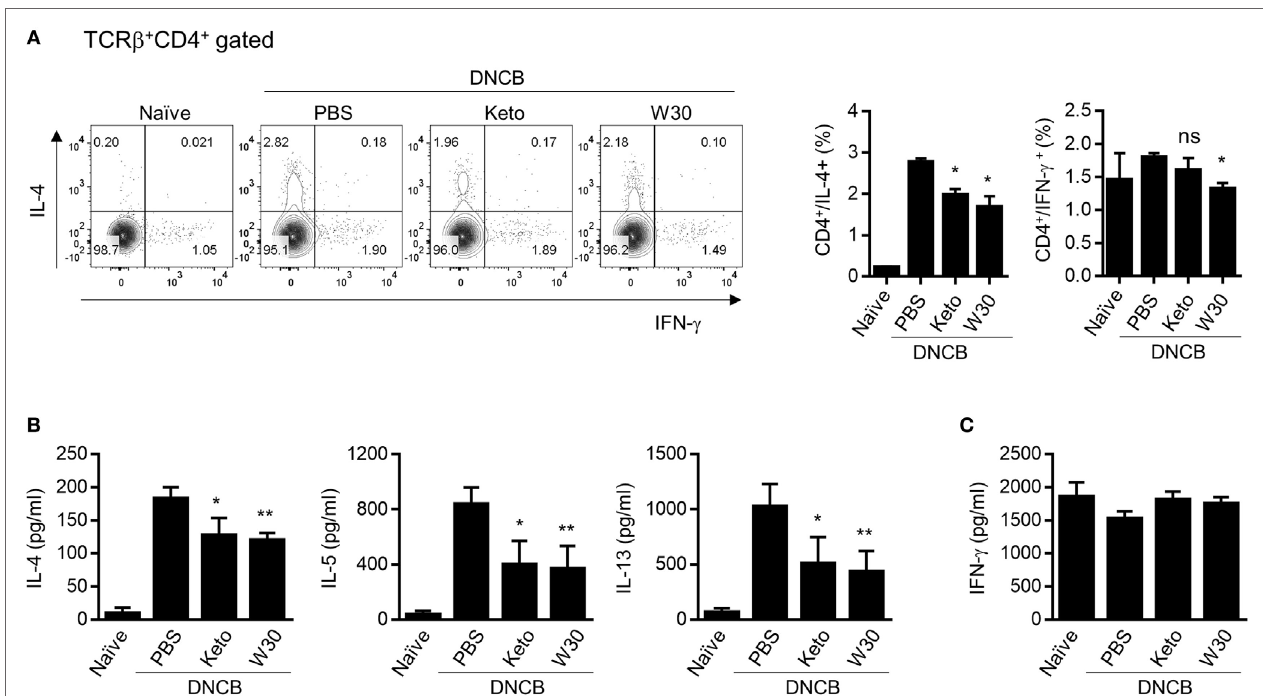
FigUre 3 | Inhibitory effect of T helper 2 immune responses in PLN cells of atopic dermatitis (AD) mice treated with WIKIM30. (a) PLN cells isolated from each group were treated with PMA/ionomycin/brefeldin A for 4 h and stained for intracellular cytokines [interleukin (IL)-4 and IFN- γ ]. The percentages of IFN- γ + CD4 + and IL-4 + CD4 + T cells were measured by flow cytometry. (B,c) PLN cells were treated with anti-CD3/CD28 monoclonal antibodies for 48 h, and IL-4, IL-5, and IL-13 and IFN- γ levels in the culture supernatant were measured with a cytometric bead array kit. Data represent the mean ± SE of n = 5 mice per group from three independent experiments. Student’s t -test (unpaired); * p < 0.05, ** p < 0.01 vs. AD